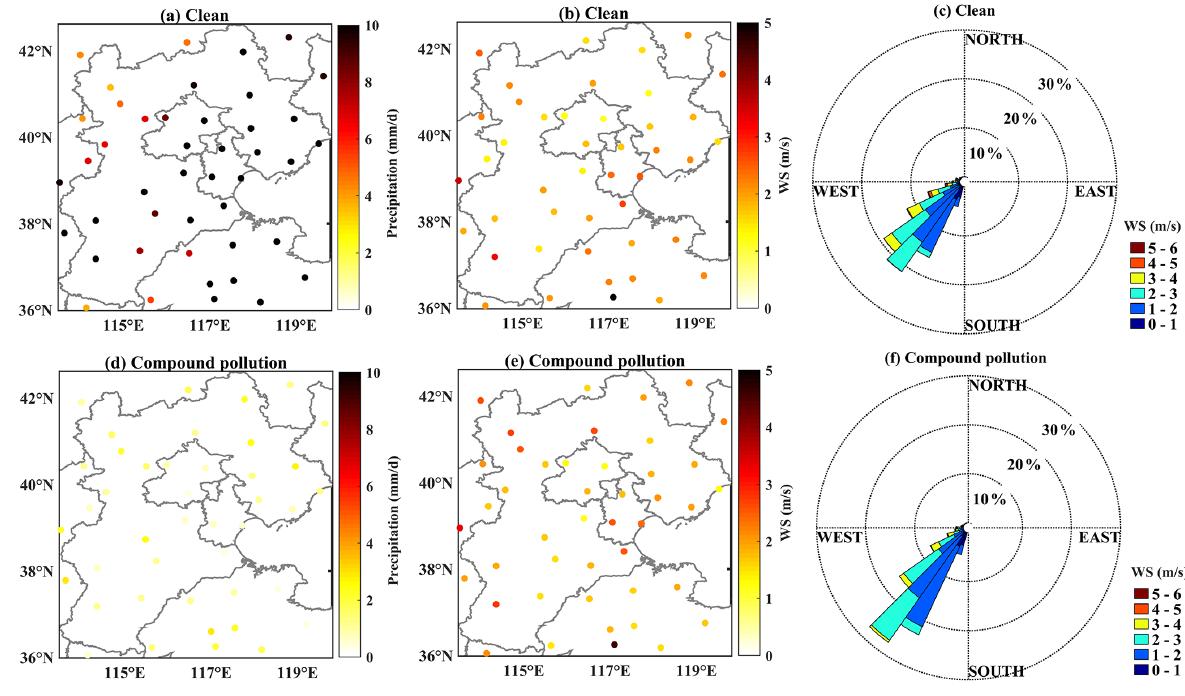
Figure 13. As in Fig. 12 but for Type 2.